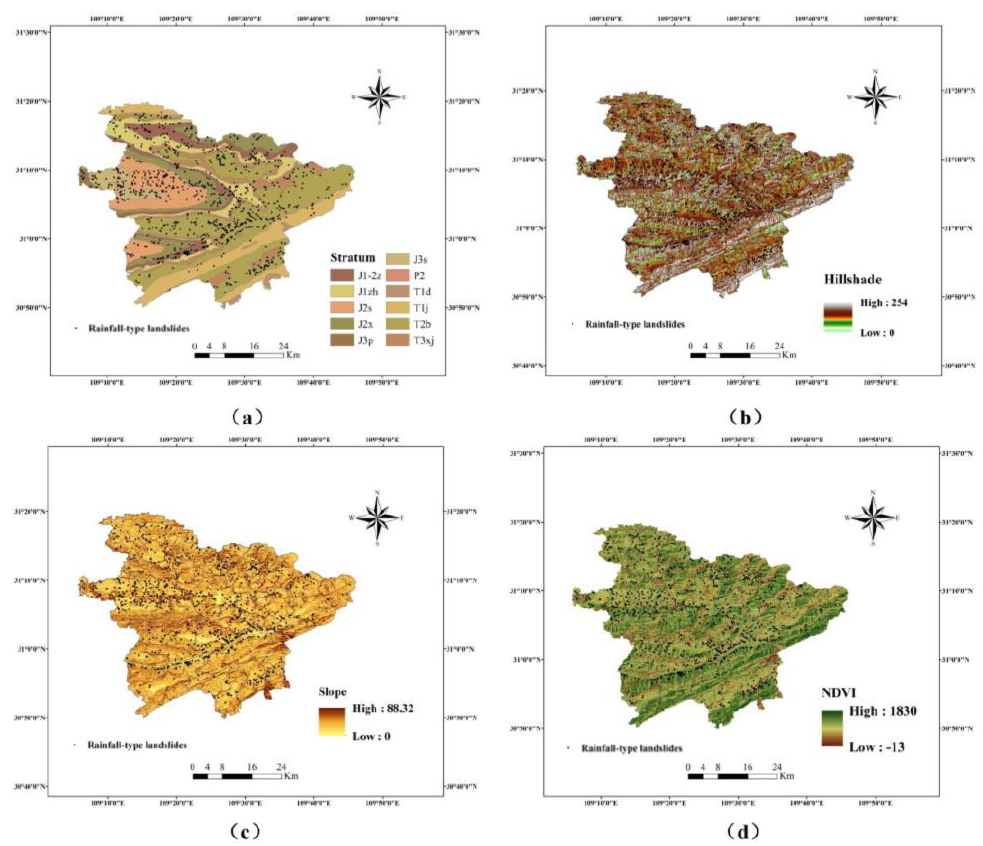
Figure 2. Thematic maps in Fengjie of physical properties about landslides. ( a ) Stratum. ( b ) Hill shade. ( c ) Slope. ( d ) NDVI. Table 1. A qualitative description of the landslide area and monitoring points in the study (partly collected from the literature) will be used for the quantitative analysis in this